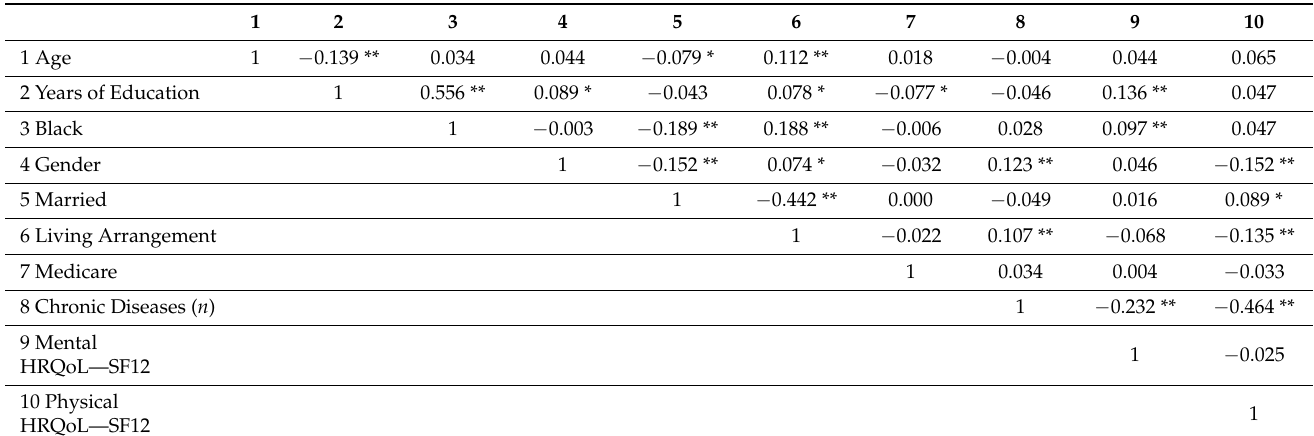
Table 2. Correlation between study variables overall.